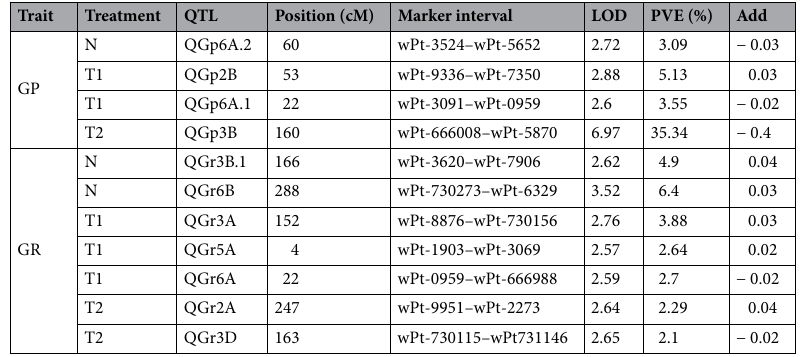
Table 3. QTLs with additive effects (Add) detected at the seedling stage under the N, T1 and T2 conditions. N, T1, T2 and T3 are the same as in Table 2.